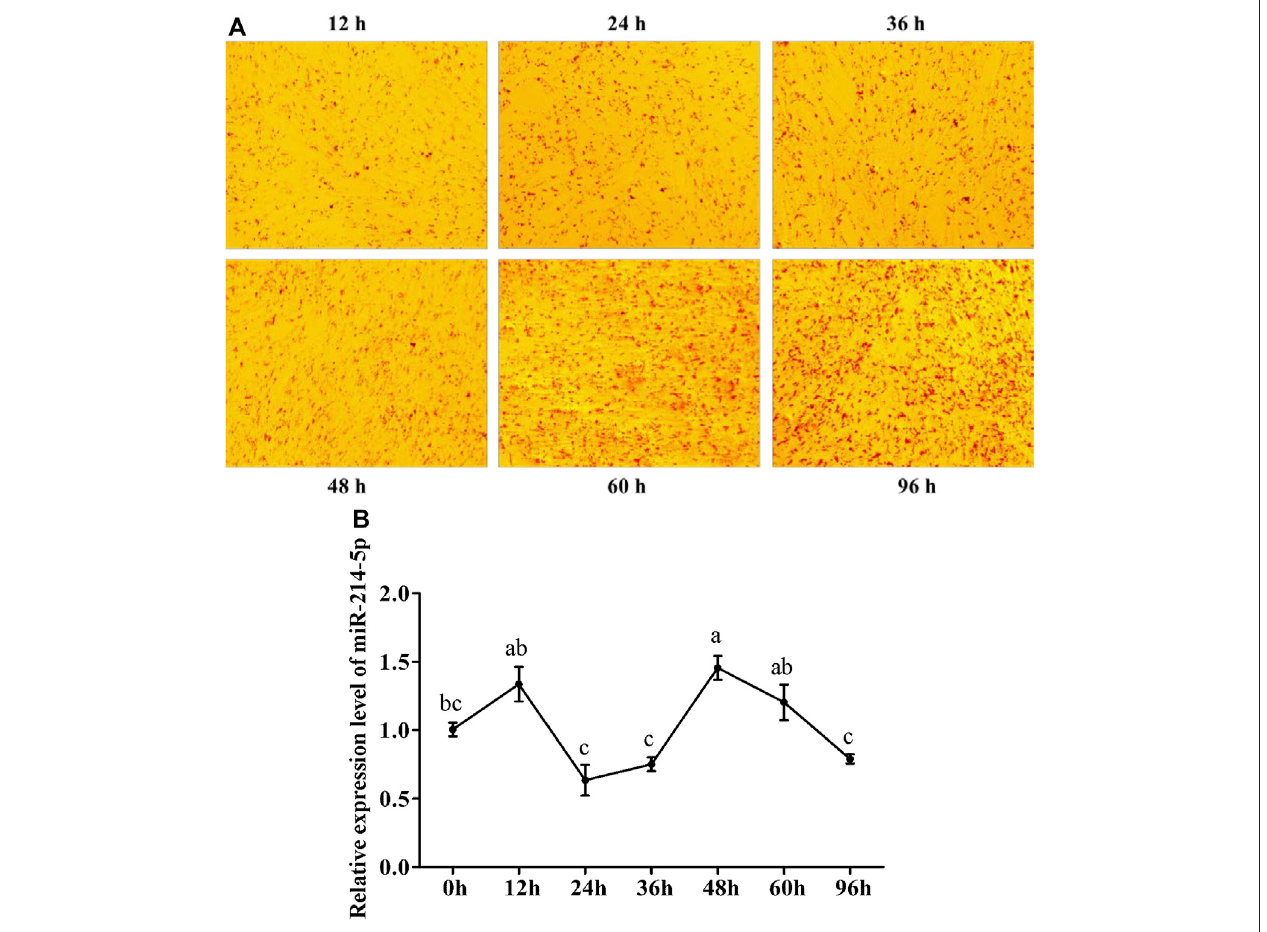
FIGURE 1 | Expression pattern of miR-214-5p. (A) Oil Red O staining of goat intramuscular preadipocytes with adipogenic differentiation at different times. (B) Expression level of miR-214-5p in different stages of goat intramuscular adipocytes. * p < 0.05; ** p < 0.01 vs. NC.